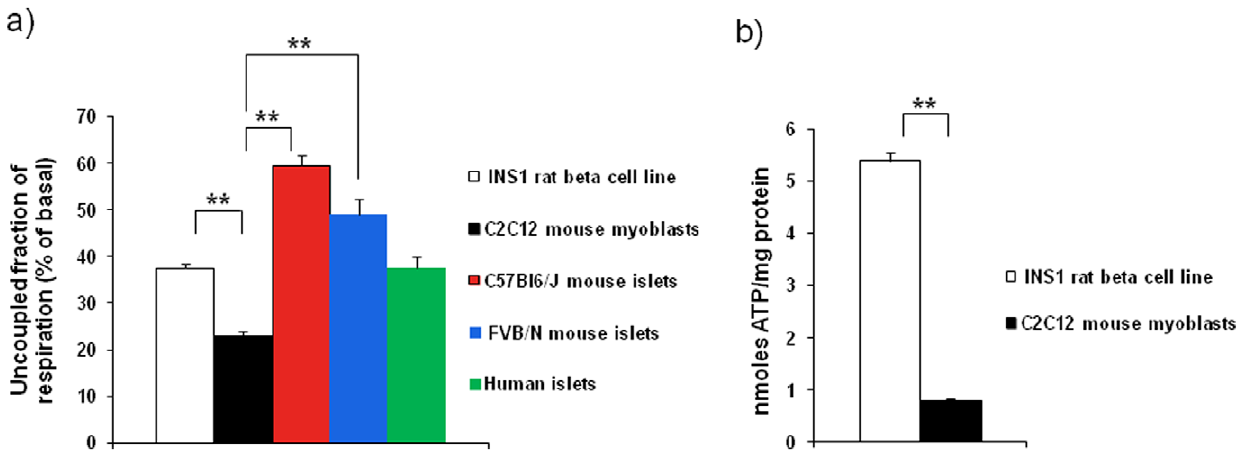
Figure 3. Islets are highly uncoupled; mice islets more than human. A) Uncoupling of wild type mouse islets, INS-1 cells, C2C12 myotubes and human islets. The graph presents a summary of multiple experiments where OCR under oligomycin (defined as uncoupling) was measured until stable. Note that uncoupled OCR is significantly higher in the mouse islets and that the C2C12 myotubes show the lowest uncoupled OCR. N=29 (INS-1), 20 (C2C12), 35 (C57Bl6/J islets), 14 (FVB/N islets), 8 (Human islets). **indicates p , 0.01. B) Comparison of total ATP levels in INS-1 cells vs.